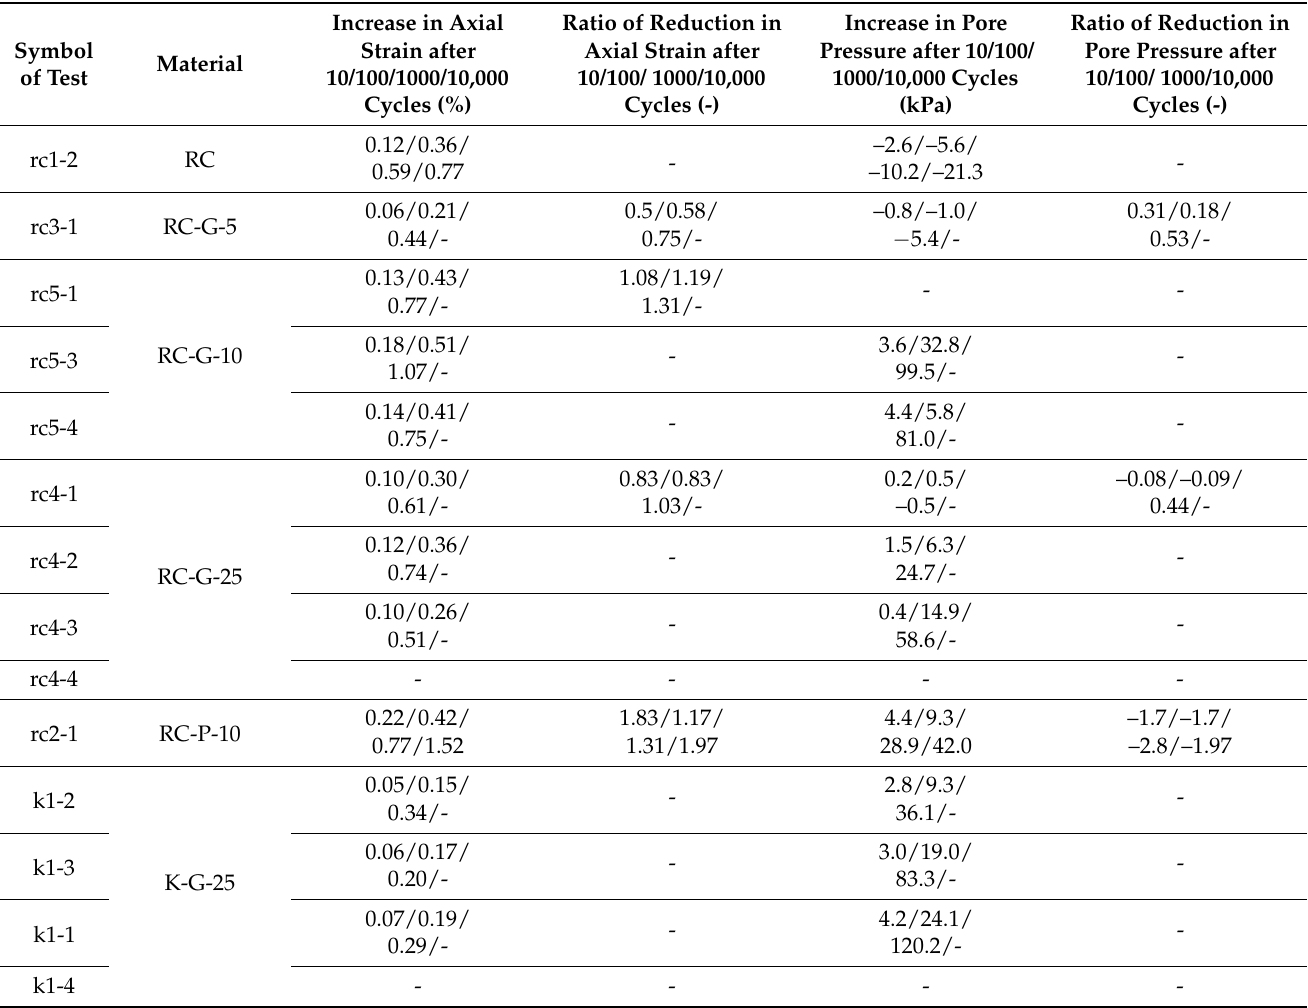
Figure 11. Strain at failure ε 1,f versus confining stress σ ’ 3 for (RC-R) and (K-R) mixtures and kaolin (K) and red clay (RC) (based on this study and tests reported in [30,51]). * Jastrz ę bska’s tests [51], ** Jastrz ę bska’s tests [30]. Table 4. Specification of axial strain ε 1,cyc and pore pressure u cyc values during triaxial tests after 10/100/1000/10,000 cycles at amplitude A = 0.35 q